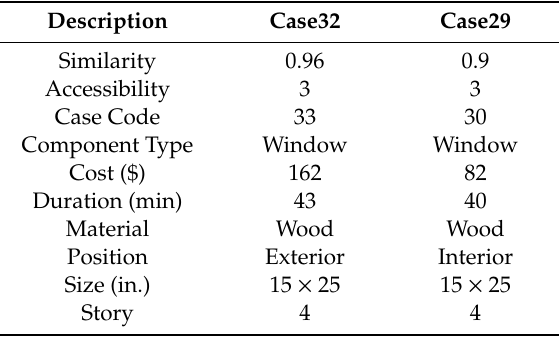
Table 3. Best matched cases from CBR model.